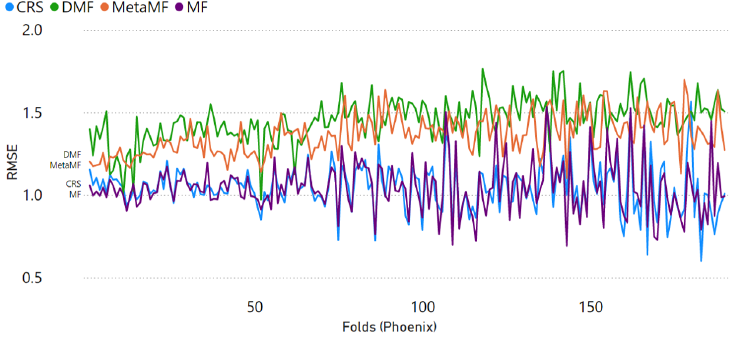
Figure 7. The RMSE comparisons among the four models for each training–test dataset pair (City of Phoenix). The dataset is partitioned chronologically. (Abscissa: value of RMSE; ordinate: index of folds).